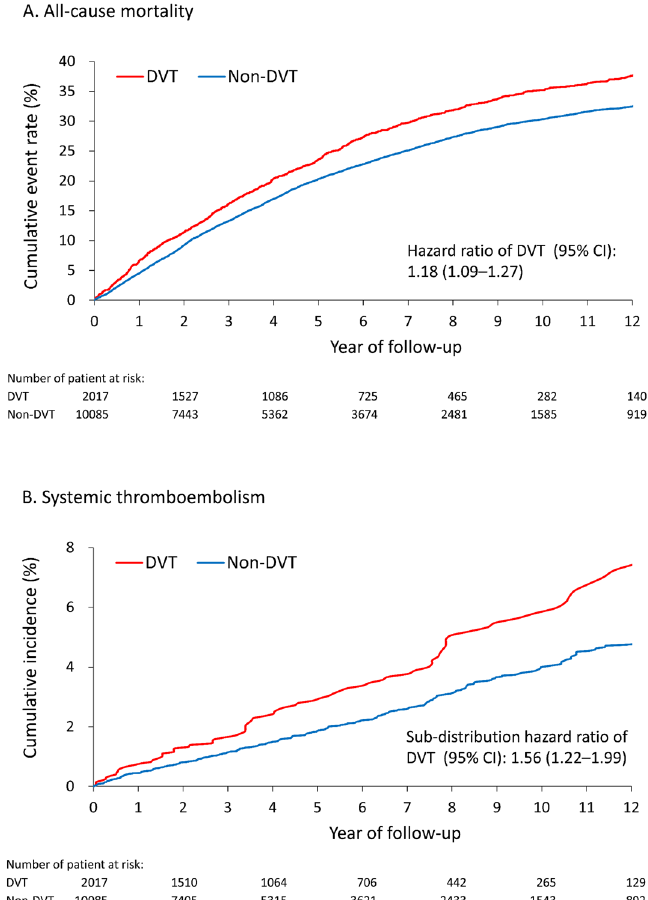
Figure 2. Cumulative event rate of all-cause mortality ( A ) and cumulative incidence function of systemic thromboembolism ( B ) of the patients with type 2 diabetes stratified by a history of deep vein thrombosis hospitalization during follow-up in the propensity score-matched